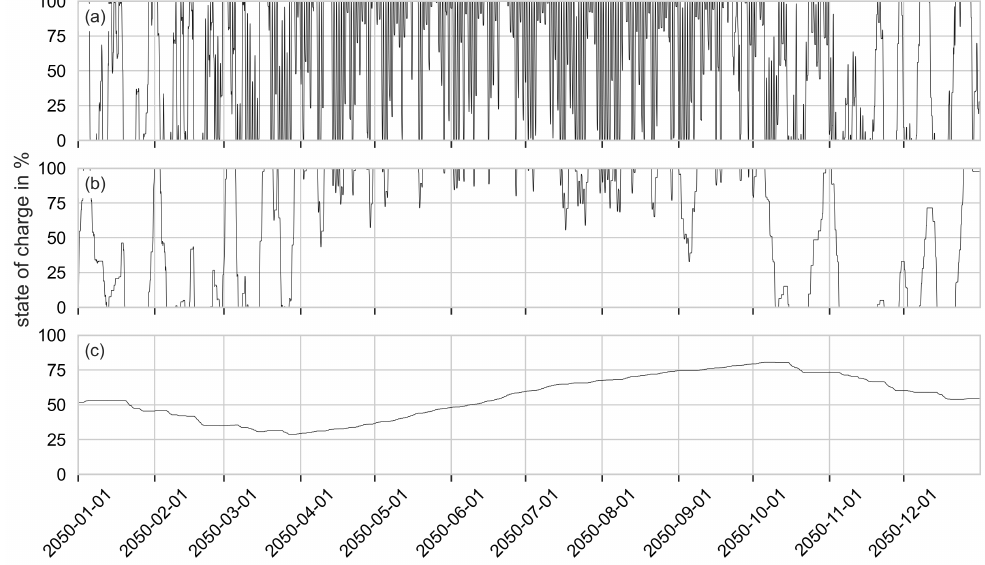
Figure 9. Example of the state of charge pattern of battery, pumped-storage hydropower, and gas storage. The upper part ( a ) shows the pattern of the battery storage, the middle part ( b ) that of pumped-storage hydropower, and the lower part ( c ) shows the state of charge pattern of the gas